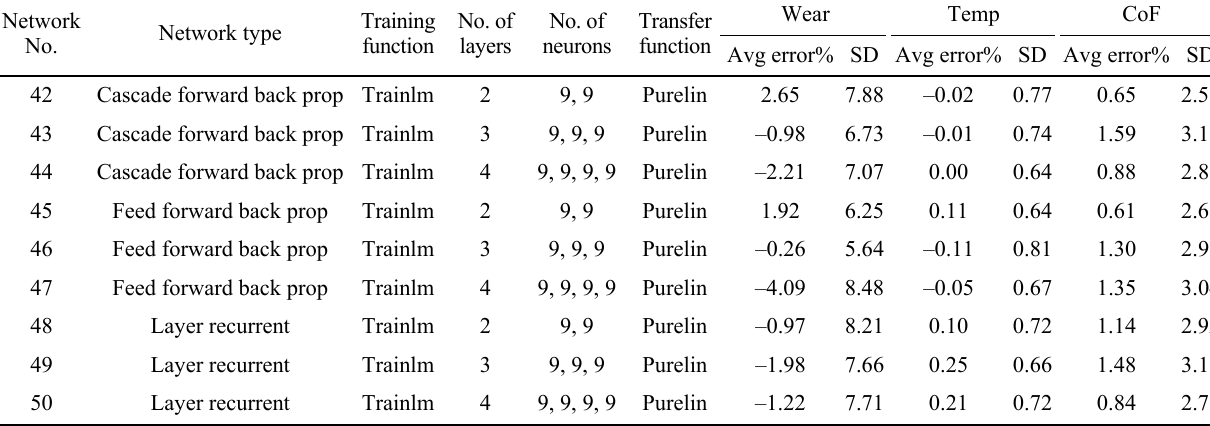
Table 18 Optimizing the network type and number of multi hidden